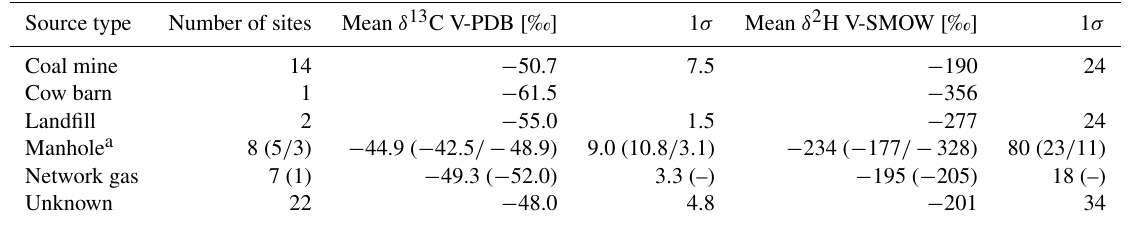
Figure 6. Dual isotope plots of the resulting source signatures from the CH 4 peaks identified in the time series. (a) Dark blue: source signatures with their associated 1 σ uncertainties. Coloured areas: ranges of source signatures obtained from the collected samples. If based on one location (ruminants and combustion), the size of the ellipse is 1 order of magnitude of the precision of our isotopic measurements. Red dots: source signatures of USCB coal gas derived from Kotarba (2001), Kotarba and Pluta (2009), and Kedzior et al. (2013). The combustion source signature is from coal waste burning samples reported in Menoud et al. (2020a). (b) Source signatures labelled by the average wind direction (colour) and speed (size) measured during the pollution event. Table 2. Isotope signatures of the different sources sampled in the region surrounding the study site. The values were used as input in the CHIMERE